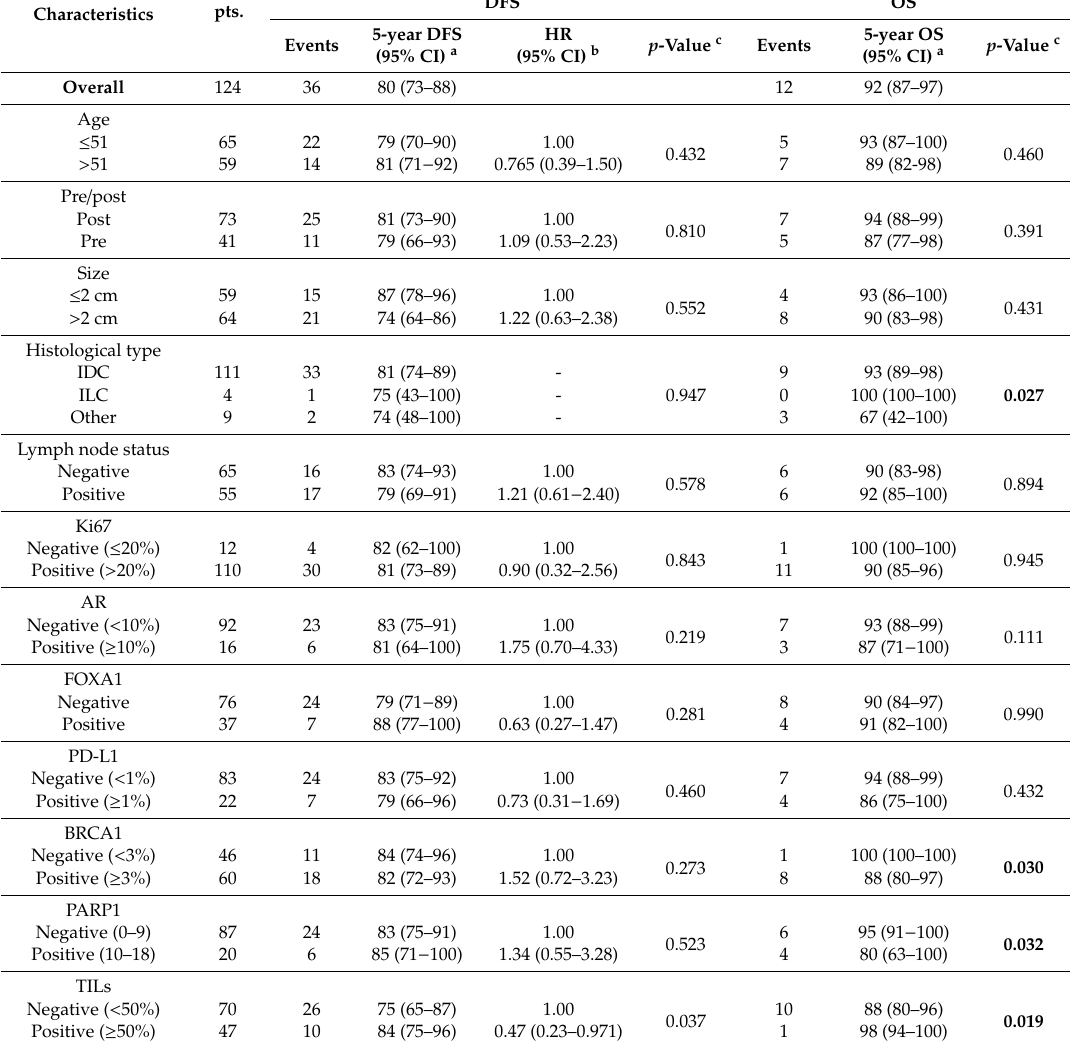
Table 2. Univariate analysis on categorical